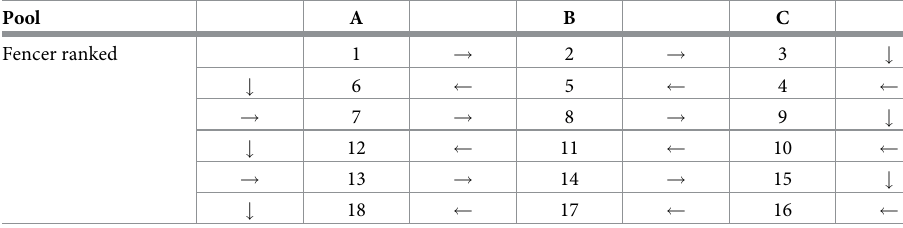
Table 1. Allocation method explained for three different pools (A, B and C), based on ranking placements of 18 competitors. Each column represents a complete pool with 6 fencers. Pool A B C Fencer ranked 1 ! 2 ! 3 # # 6 5 4 ! 7 ! 8 ! 9 # # 12 11 10 ! 13 ! 14 ! 15 # # 18 17